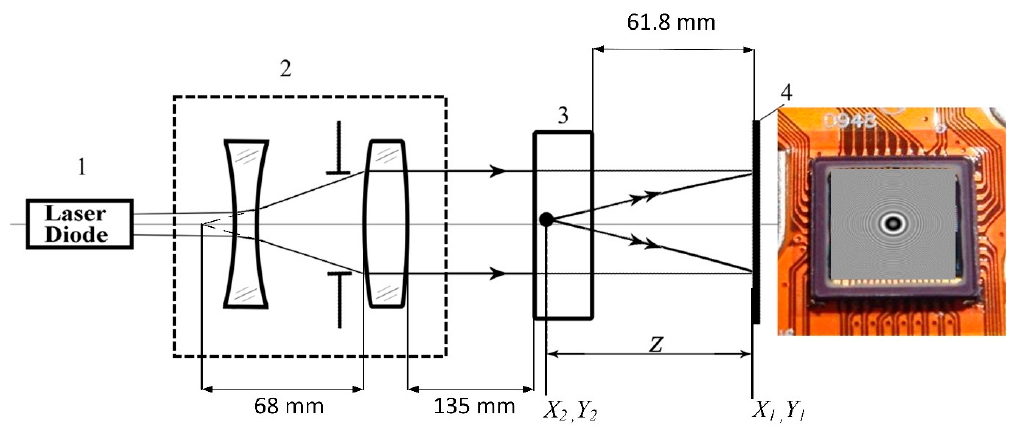
Figure 1. In-line scheme of digital Gabor hologram recording comprising laser—1, expander—2, investigated sample—3, and Videoscan-2020/PC CMOS camera—4.